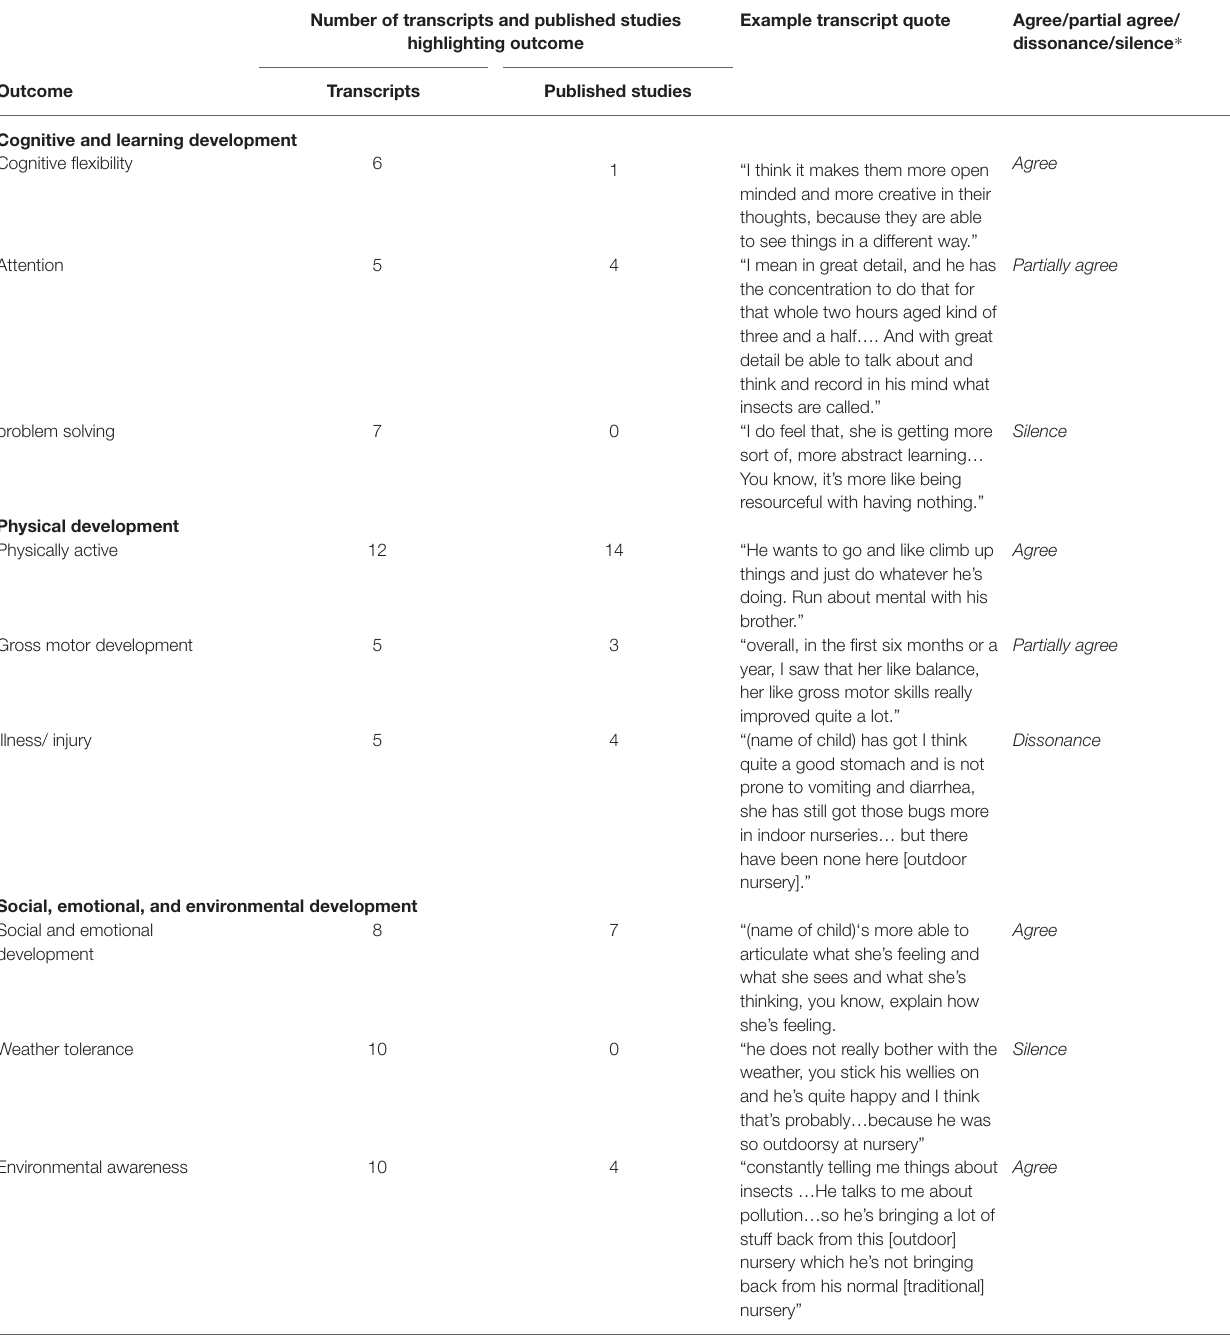
TABLE 3 | Extract from the triangulation of transcript analysis with analysis of the published studies extracted from a systematic literature search to determine outcomes to be included in the logic model. Number of transcripts and published studies highlighting Outcome